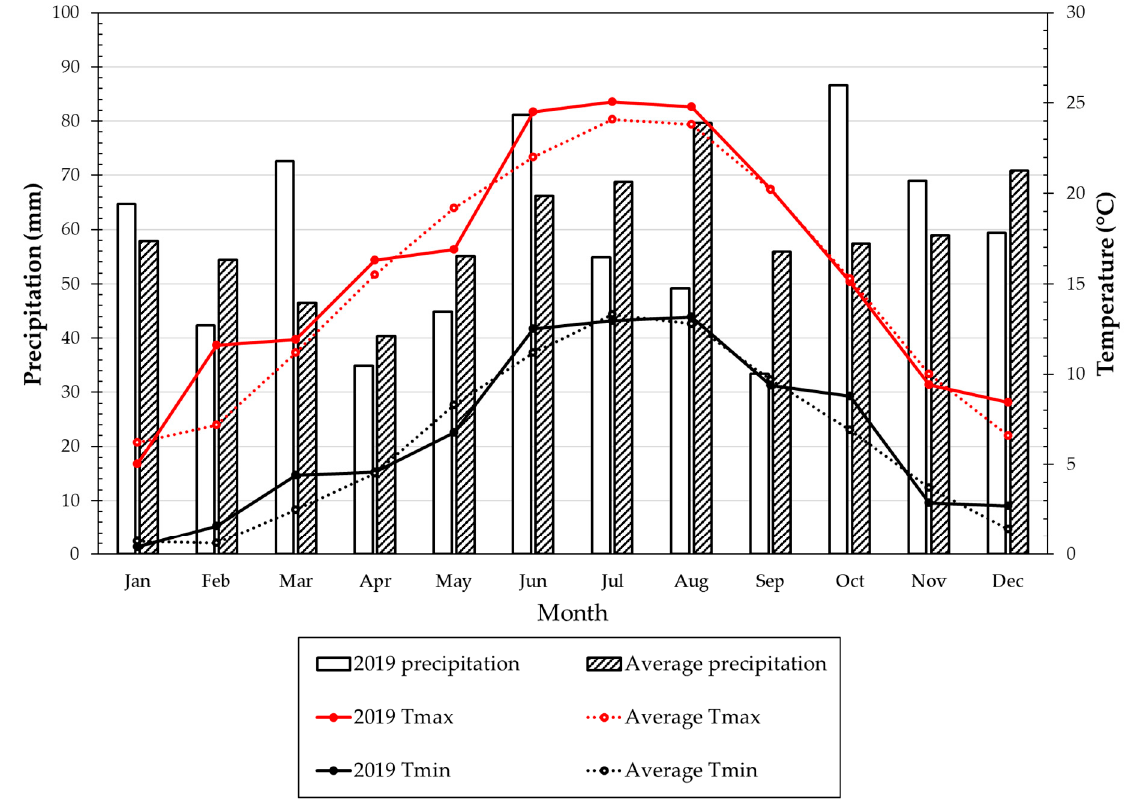
Figure 5. Precipitation (mm), maximum temperature (Tmax-°C) and minimum temperature (Tmin- °C) in Landen for the experimental period (January–December 2019) and the 1991–2020